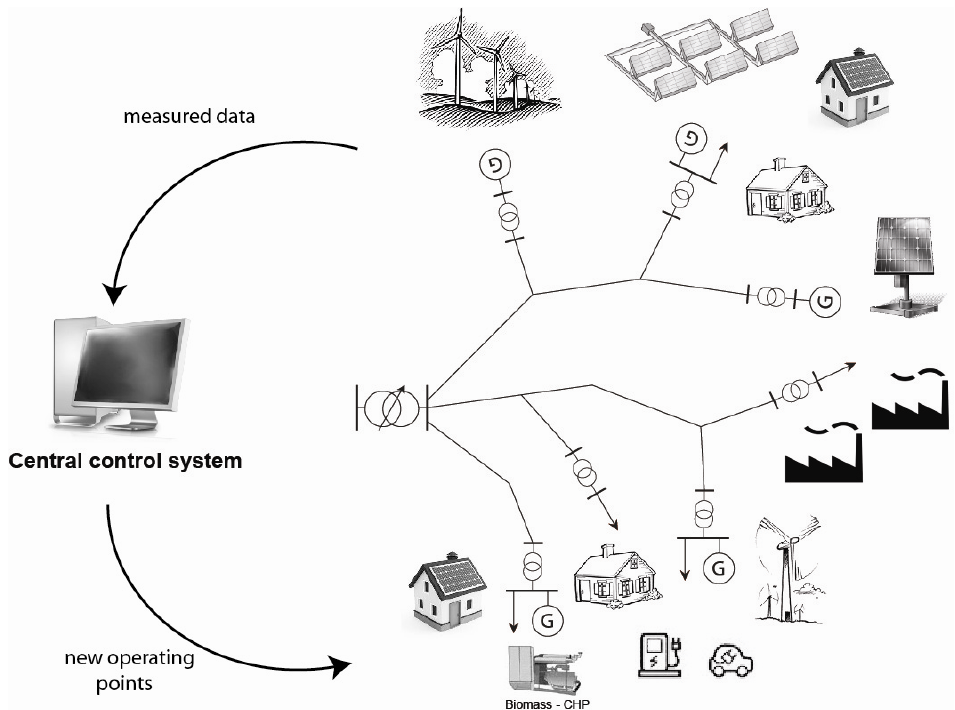
Figure 3. Active distribution